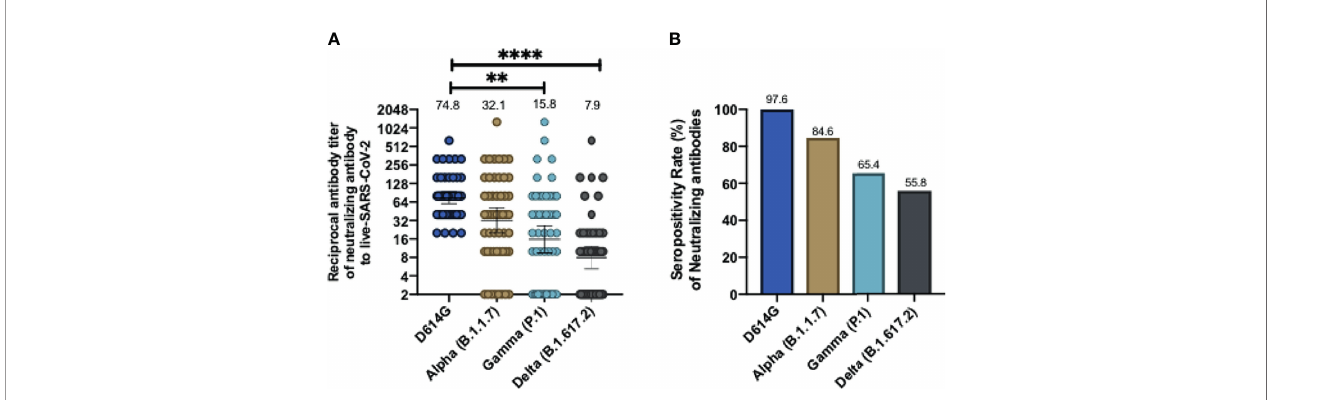
FIGURE 2 | CoronaVac immunization induces neutralizing antibodies against SARS-CoV-2 variants after two vaccine doses using a conventional virus neutralization test. Neutralizing antibody titers were evaluated by incubating the serum with a SARS-CoV-2 Chilean clinical strains and then added into Vero E6 cell for seven days. The neutralizing titer was determinate for the last dilution where no viral cytopathic effect was found in cells against wild type (D614G), and Alpha, Gamma and Delta variants. Consolidate neutralizing antibodies titer of both schedules is shown in (A) , and the seropositivity rate of neutralizing antibodies is shown in (B) . Numbers above the bars show the Geometric Mean Titer (GMT), and the error bars indicate the 95% CI in (A) , and the number above bars in (B) showed the seropositivity rate. A Wilcoxon test analyzed data to compare against the wild-type RBD; **p < 0.005, ****p < 0.0001. The graph represents the results obtained for 52 volunteers of both